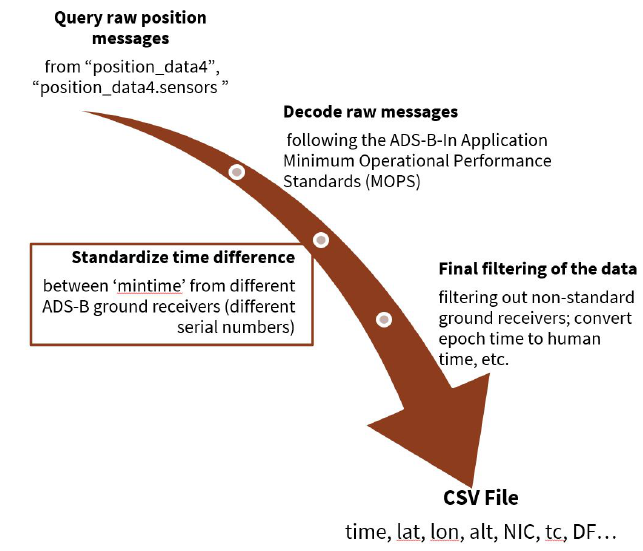
Figure 1. Flowchart of ADS-B data